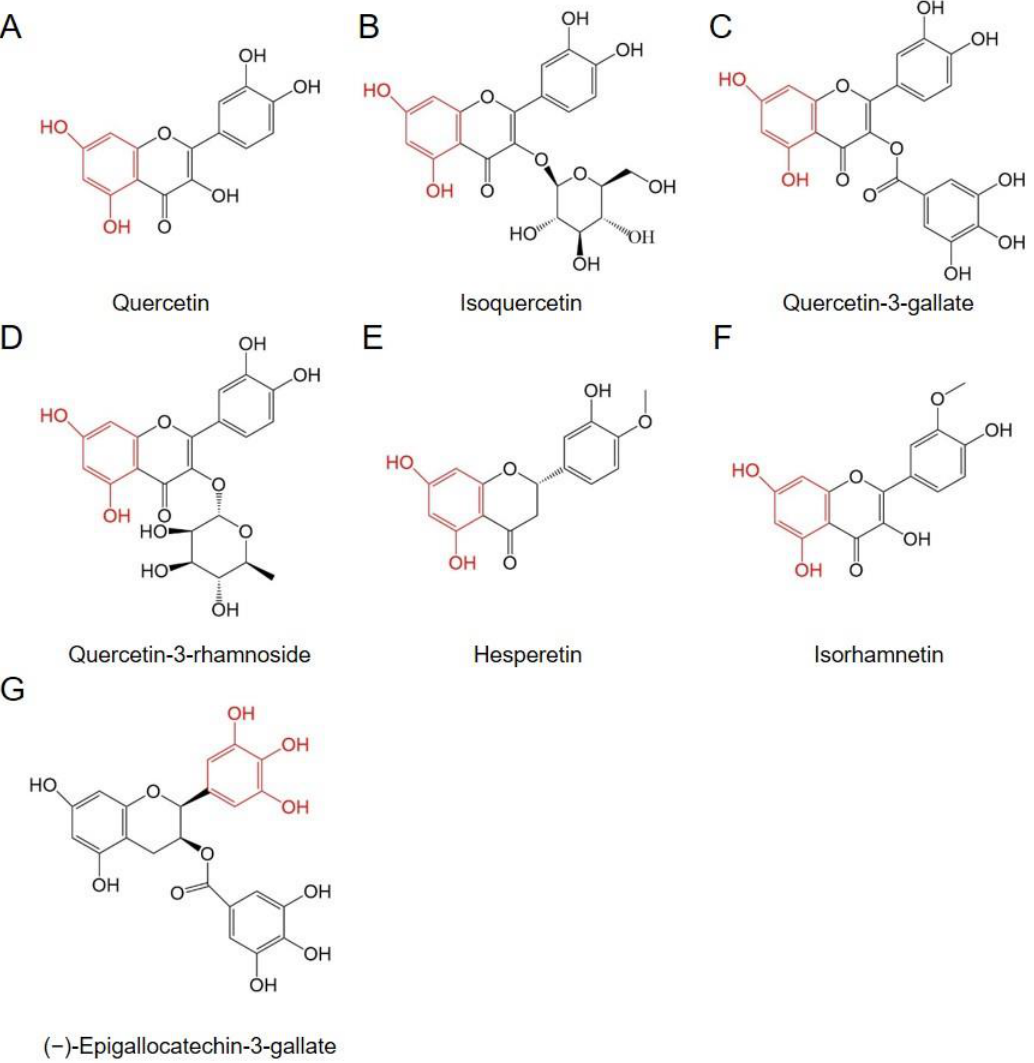
Figure 5. The molecular structure of quercetin and its analogs as HSP inhibitors. ( A ) Quercetin. ( B ) Isoquercetin. ( C ) Quercetin-3-gallate. ( D ) Quercetin-3-rhamnoside. ( E ) Hesperetin. ( F ) Isorham- netin. ( G ) (−)-Epigallocatechin-3-gallate.